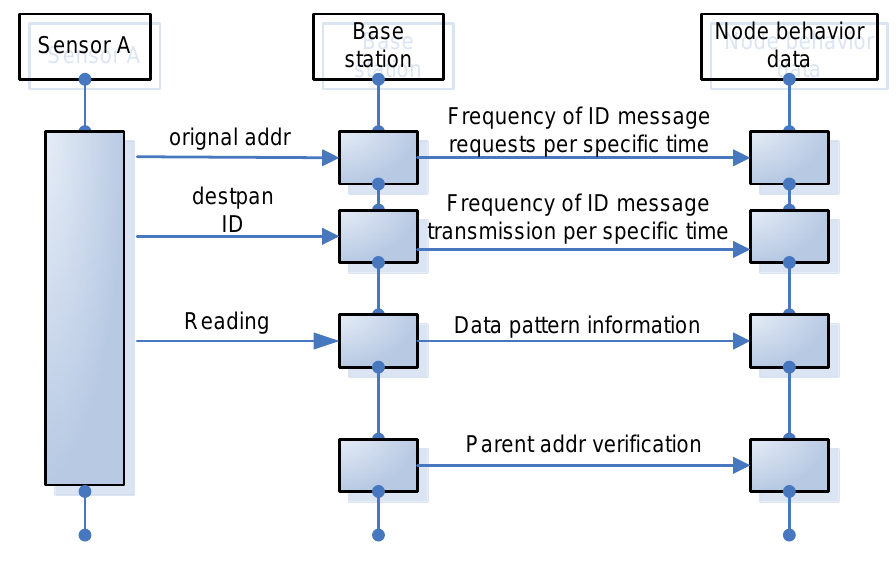
Figure 6. Process of verifying behaviors between